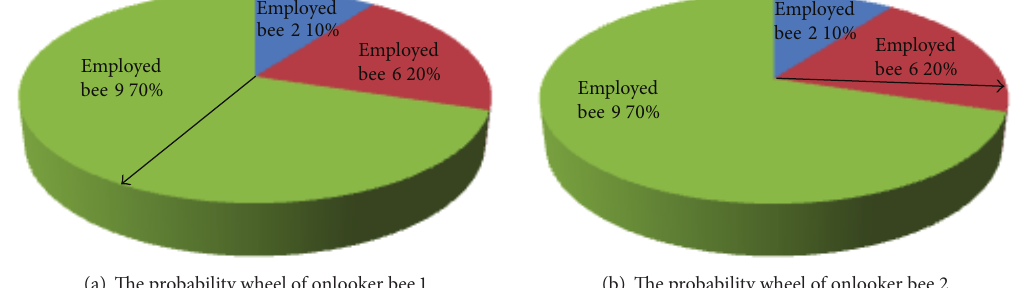
Figure 2: Examples of the probability wheel for onlooker bees.